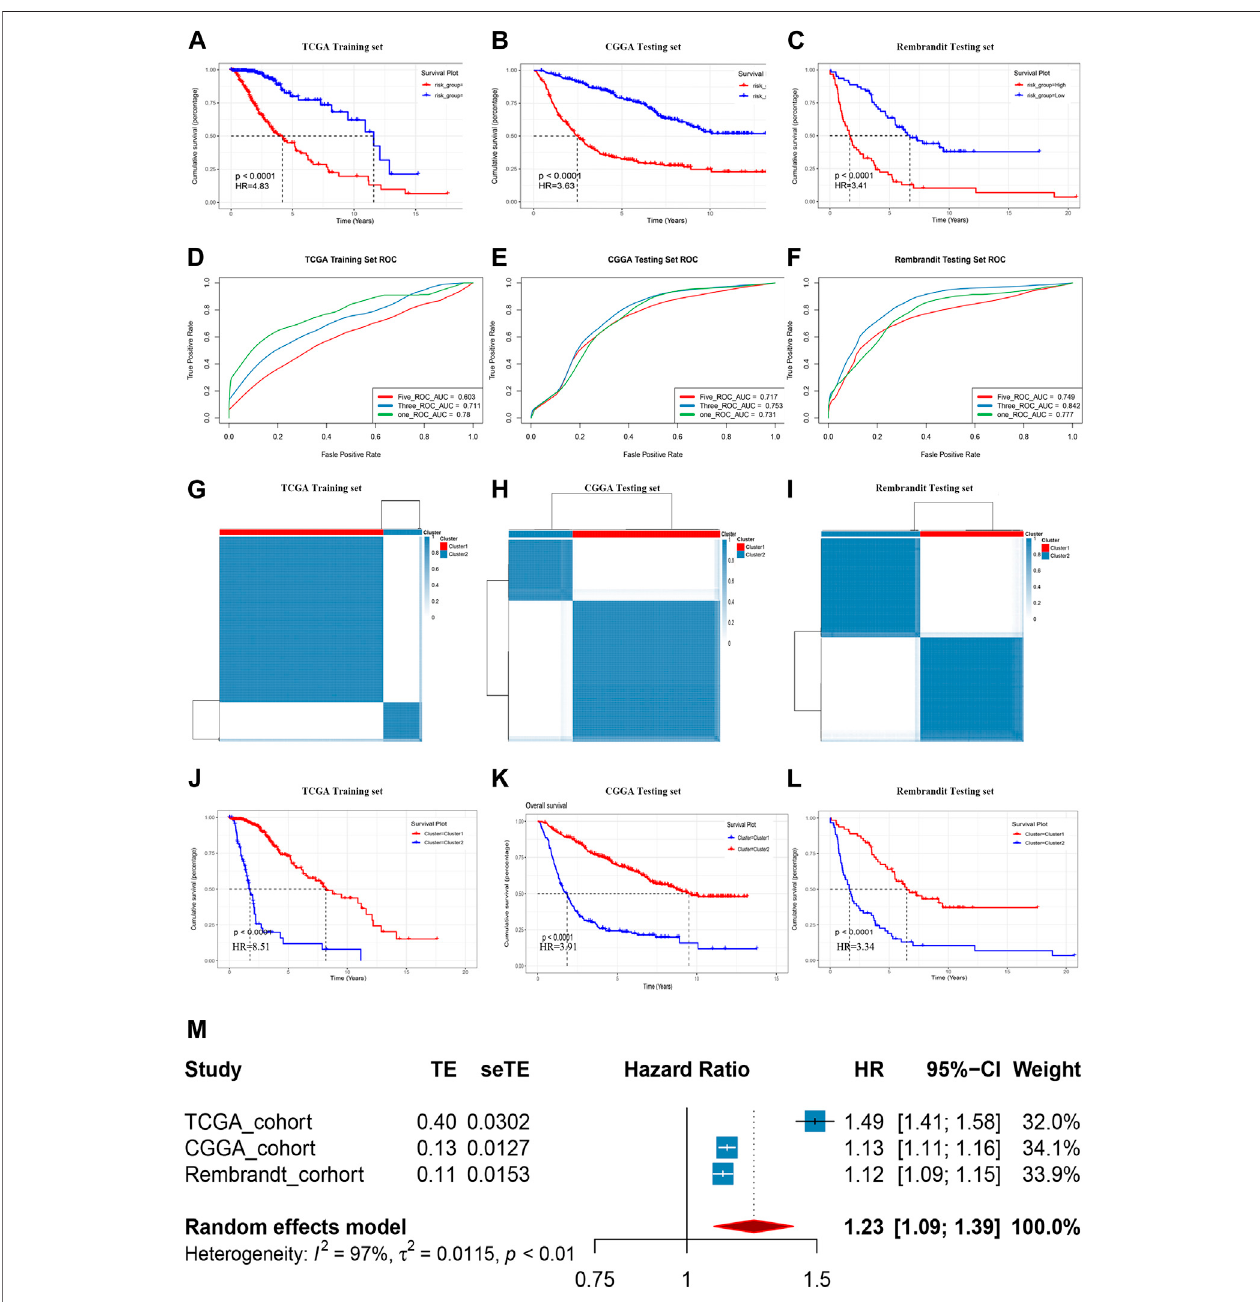
FIGURE 4 | Prognostic risk score features of glycolysis-related genes in the training and testing cohorts. (A-C) Kaplan – Meier survival curve in the Rembrandt cohort, CGGA cohort, and TCGA cohort. (D-F) ROC curves of the GRS on OS in the three cohorts. (G-I) Sample clustering heat maps of the three cohorts generated usingtheK-meanclusteralgorithm. (J-L) Kaplan – MeiersurvivalcurveinrespectivelyclustersgeneratedbyK-meanclusteralgorithminthreecohorts. (M) Meta-analysis of training cohort and testing cohorts.